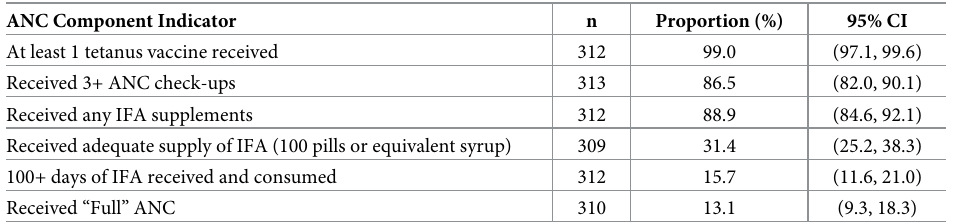
Table 5. LQAS sample size (n) and point estimates for ANC component